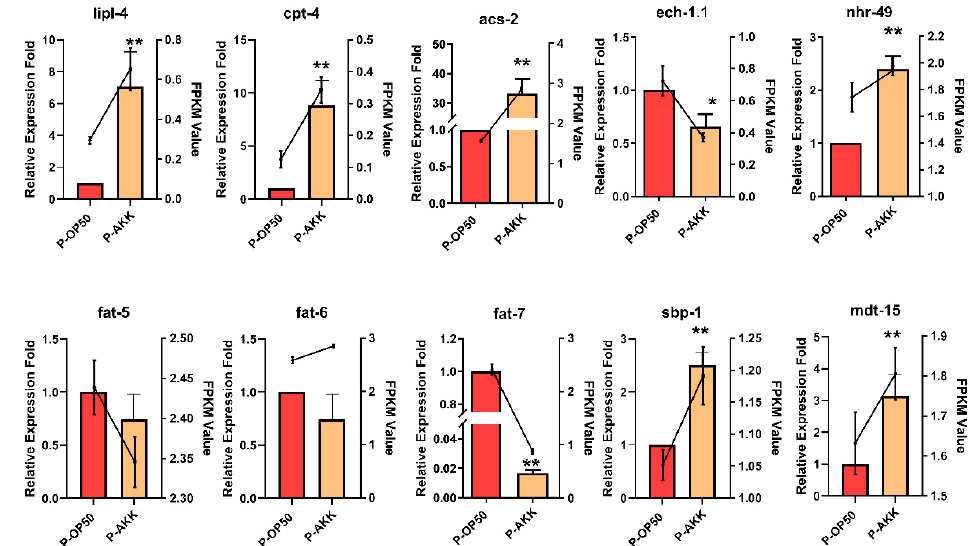
Figure 6. qRT-PCR analysis of expression of 10 DEGs. Line charts are from the transcriptome data results (FPKM value). Column charts are from the qRT-PCR results (relative expression fold change). Bars represent means ± SD (N = 3). Using an independent sample t -test, statistically significant differences and extremely significant differences were defined as (*) p < 0.05 and (**) p < 0.01 compared to the P ‐ OP50 group, respectively.